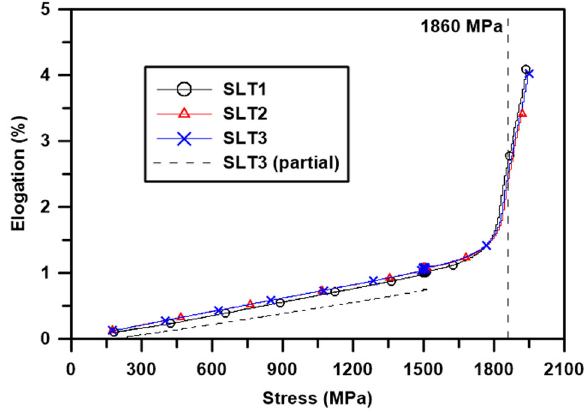
Fig. 8 Relationship between elongation percentage and stress.